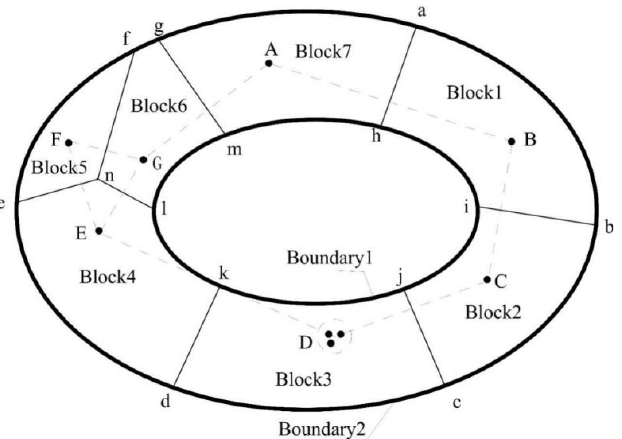
Figure 3. Geological units divided by the adjacent area method of geological stations: Boundaries 1 and 2 are the upper-line boundary lines of the seamount cobalt-rich crust ore body. Black dots are survey stations. Points A, B,..., F are geological stations. Points a, b, c are the intersection of the normals of the line connecting each of the two stations with the two boundaries. Block refers to a geological unit.